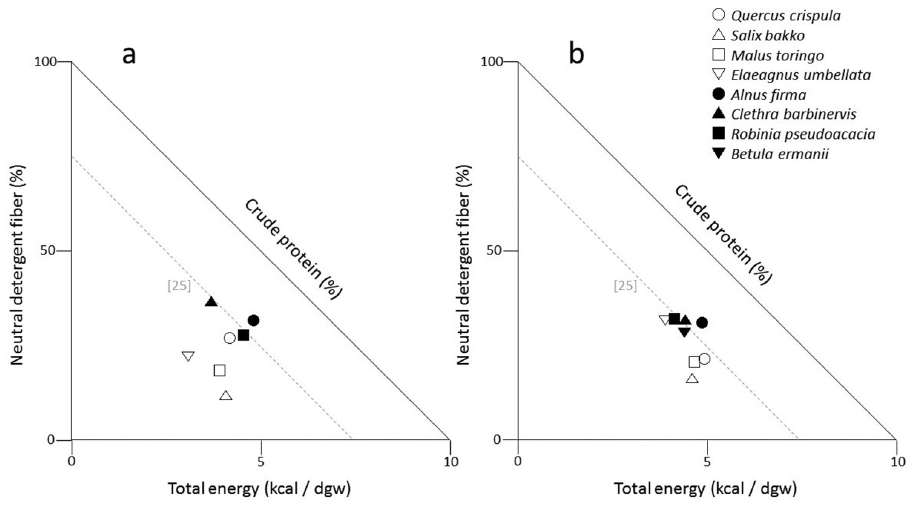
Figure 3. Right-angled mixture triangles (RMT) depicting the macronutrient balance of Quercus crispu- la , Salix bakko , Malus toringo , Elaeagnus umbellata , Alnus firma , Clethra barbinervis , Robinia pseudoacacia, and Betula ermanii leaves in early and late May. The RMT on the left a is early May, while the RMT on the right b is late May. Crude protein is represented on the implicit axis which varies inversely with distance from the origin (the dashed gray line indicates 25% protein